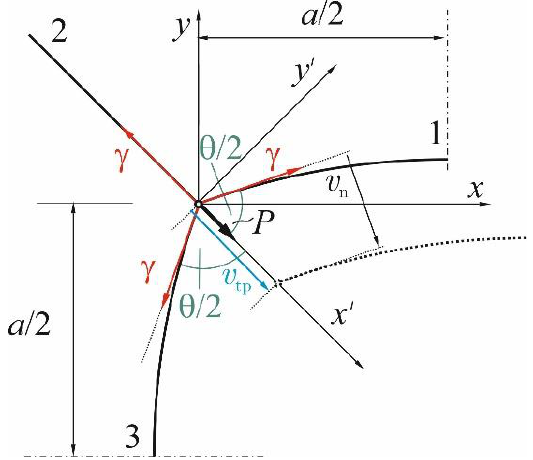
Figure 3. Schematic sketch of the forces at the triple junction, the net driving force P , the velocity v tp of the triple junction and the normal velocity v n of e.g., the grain boundary 1 at the triple point. The angle ( θ /2 = π /4 + α ) equals ϕ in Equation (12) of reference [32]. Thus, the term sin ϕ = sin ( θ /2 ) should be in the denominator as in Equation (6), and not in the numerator, as in Equation (12) of reference [32], or in the same equation, Equation (26) of reference [35]. The velocity v tp at the triple point is linearly proportional to the net driving force P :